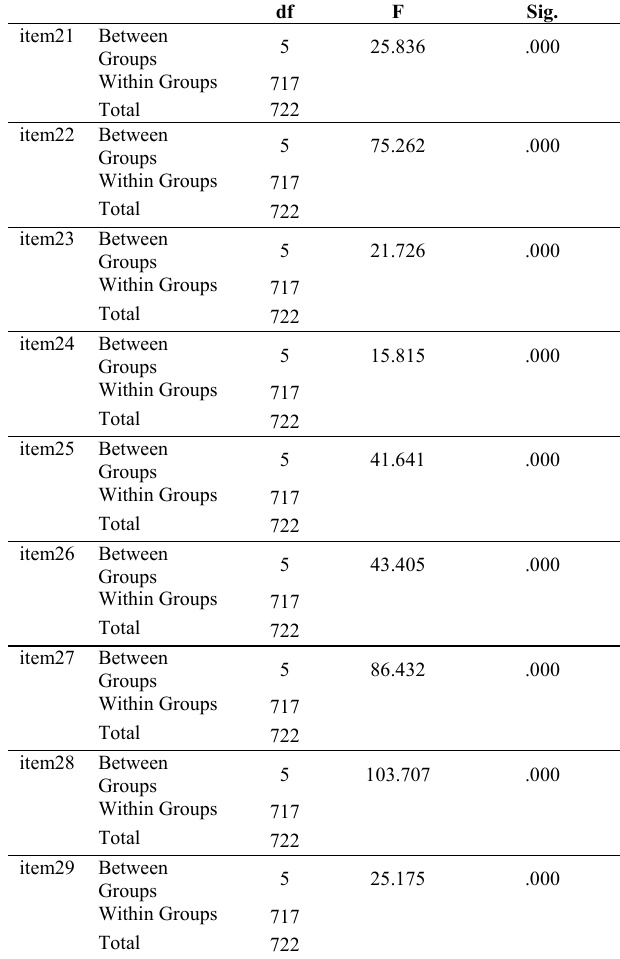
Table 15: The ANOVA for the influence of the features of furniture product design on the fuzzy semantics